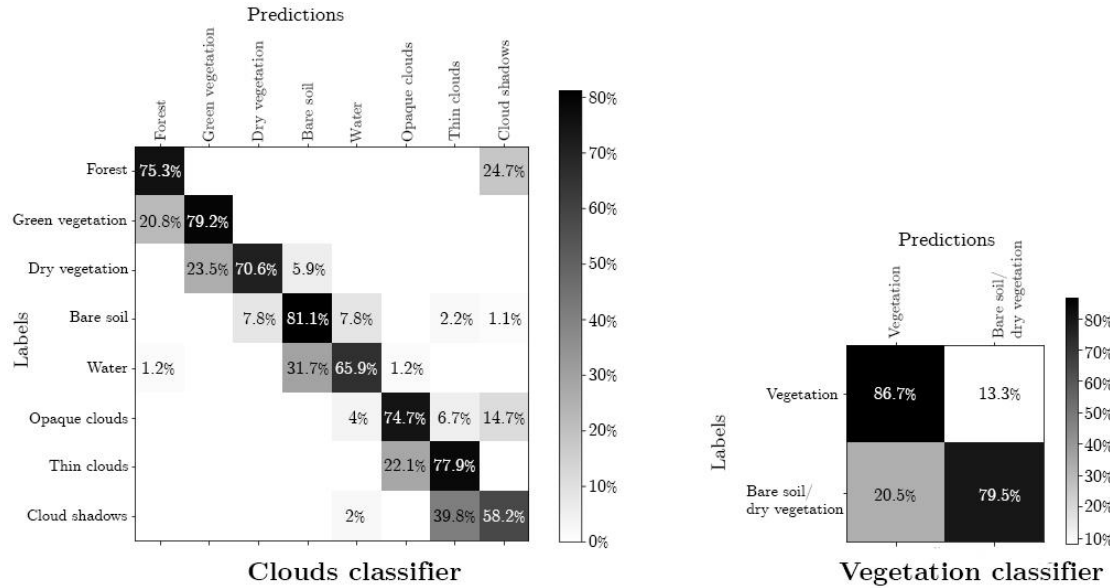
Figure 8. Normalized confusion matrices in the percent of pixels for the trained classifiers comparing predictions with labels of the classified data.